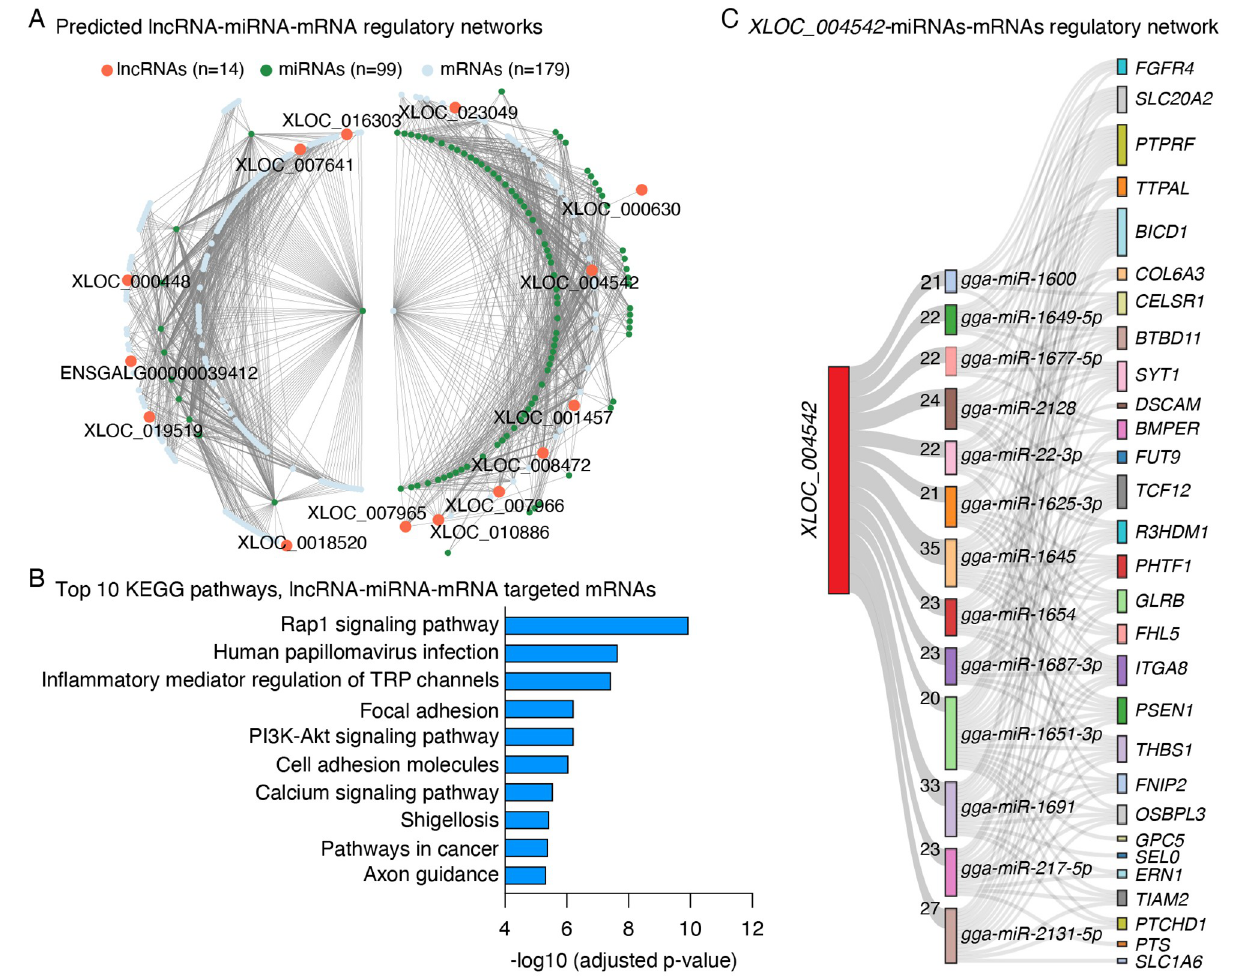
Fig 5. Construction of lncRNA-miRNA-mRNA regulatory network. (A) Predicted lncRNA-miRNA-mRNA regulatory network. LncRNAs with at least 10 predicted binding sites for at least 1 miRNA associated with ALV invasion were included. (B) Top 10 most significantly enriched KEGG pathways for the 178 differentially expressed protein coding genes identified in the lymphoma samples and potentially regulated by lncRNA-miRNA axis. (C) Sankey diagram showing the regulatory network mediated by the novel lncRNA XLOC_004542 that harbors the largest number of predicted miRNA binding sites. The width of lines linking XLOC_004542 and miRNAs is proportional to the putative number of miRNA binding sites, which is labeled on the